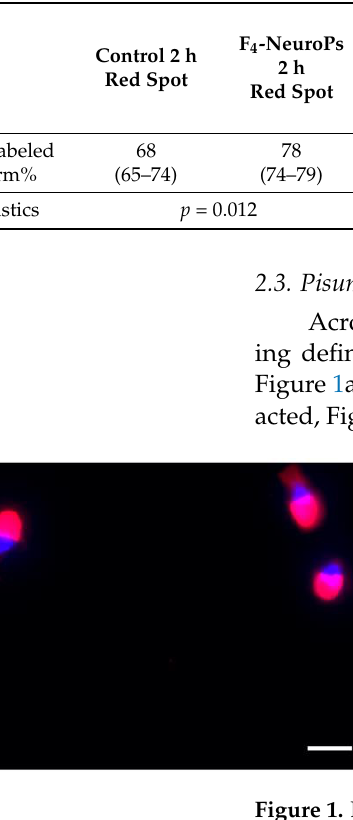
Table 2. Median (IQR) percentage of sperm with JC-1 labeling (high MMP potential), showing as a red spot or strong red signal after incubation with 7 ng F 4 -NeuroPs or without F 4 -NeuroPs (control) for 2 and 4 h. p < 0.05 is considered significant.